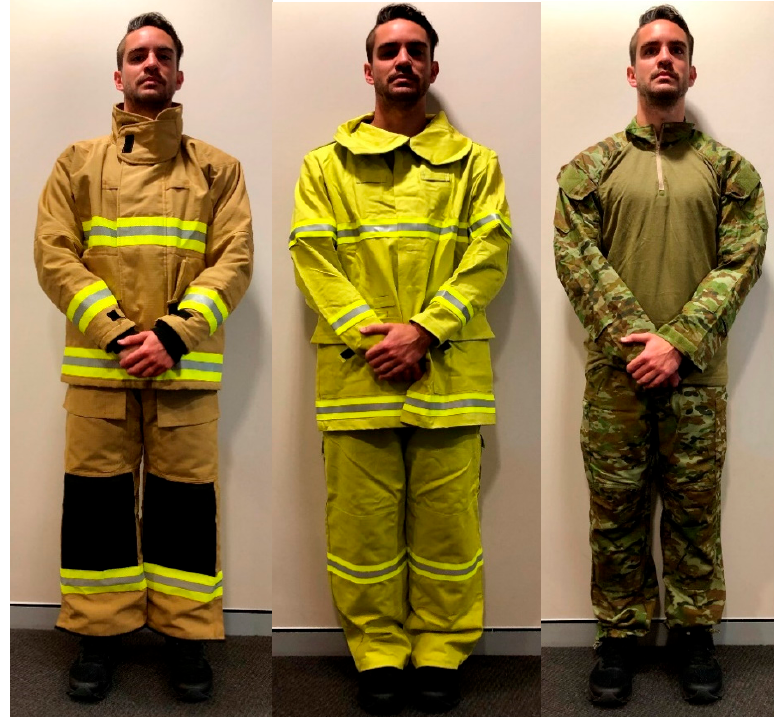
Figure 1. Clothing variation 1 (V1), variation 2 (V2), and variation 3 (V3).